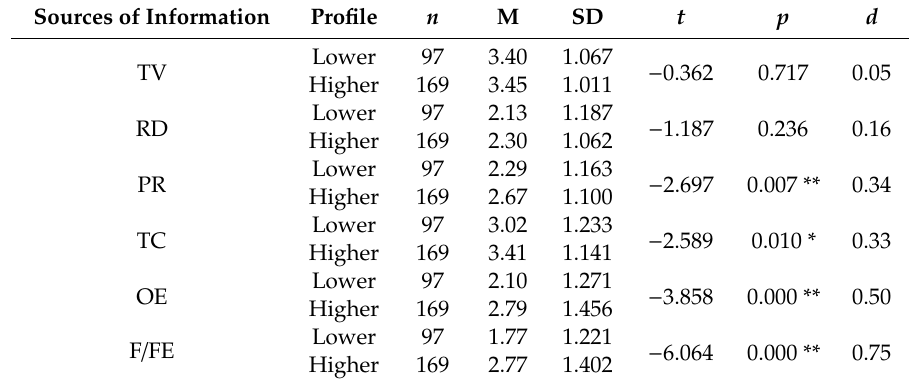
Table 3. Significant di ff erences in the sources of information between the groups with a higher and lower knowledge of situations of violence.